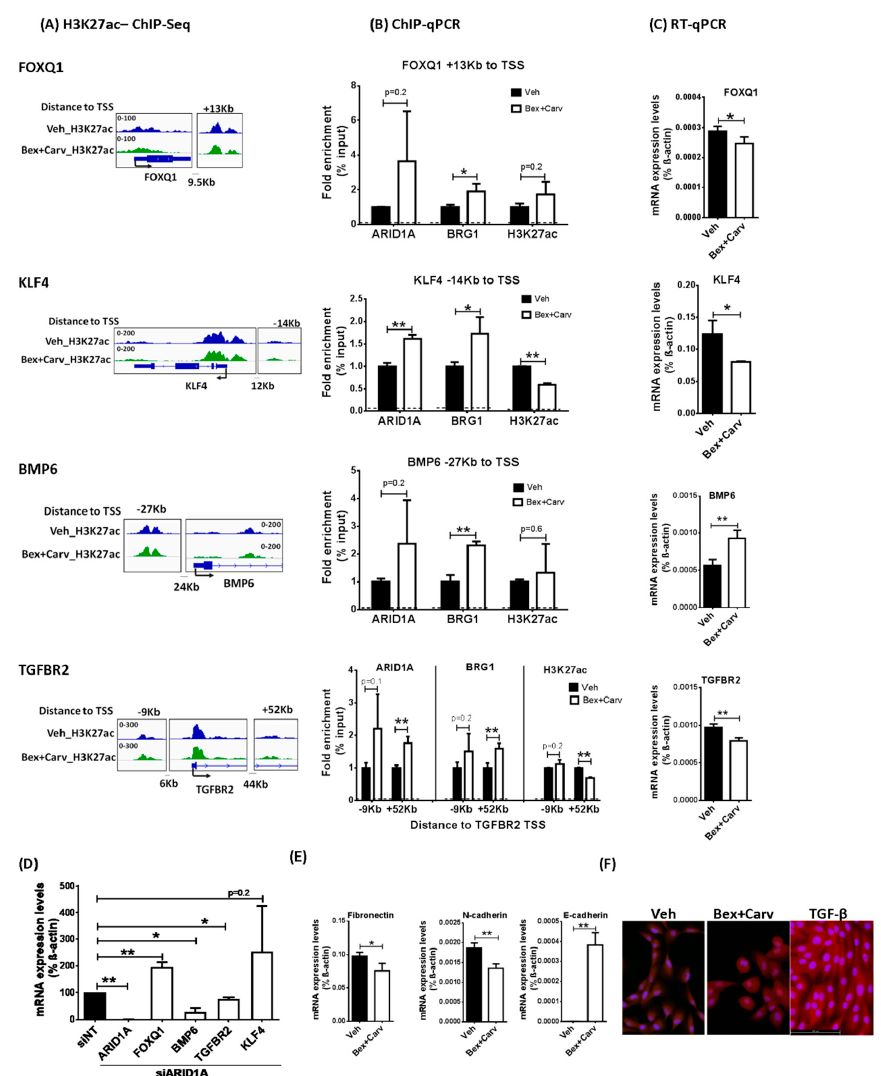
Figure 2. Recruitment of ARID1A to regulatory elements of TGF- β signaling pathway genes upon Bex+Carv treatment and associated change in target gene expression and phenotype in HME-hTert cells. ( A ) ChIP-Seq tracks of H3K27ac in control and Bex+Carv-treated HME-hTert cells across FoxQ1, KLF4, BMP6, and TGFBR2 genes showing the promoter and the studied regulatory regions, exported from the Integrative Genomics Viewer (IGV) application. ( B ) Quantitation of ARID1A and Brg1 enrichment and H3K27ac marks to the putative regulatory elements assigned to FoxQ1, KLF4, BMP6, and TGFBR2 genes after Veh or 100 nmole/L Bex + 1000 nmole/L Carv treatment for 6 h in HME-hTert cells. N = 3 representing 3 biological replicates. The dashed line represents the signal derived from the negative control sample. ( C ) RT-qPCR analysis of target gene transcript levels upon Vehicle or 100 nmole/L Bex + 1000 nmole/L Carv treatment for 6 h in case of KLF4 and BMP6 and 24 h in case of FoxQ1 and TGFBR2. N = 3 representing 3 biological replicates. ( D ) RT-qPCR analysis of ARID1A, FoxQ1, BMP6, and KLF4 gene expression upon 20 nmole/L siRNA transfection for 48 h, and TGFBR2 gene expression upon 72 h of 20 nmole/L siRNA transfection. The gene expression results are presented as a percentage relative to the control sample (siNT). N = 3 representing 3 biological replicates. ( E ) RT-qPCR analysis for the transcript levels of Fibronectin 1 after 24 h, N-cadherin after 6 h, and E-cadherin after 24 h of 100 nmole/L Bex+ 1000 nmole/L Carv combination treatment in HME-hTert cells. The results are expressed as mean ± SD * p < 0.05, ** p < 0.01 by two-tailed Student’s t -test. ( F ) Representative fluorescent images of HME-hTert cell morphology after 72 h of vehicle, Bex+Carv, or TGF- β treatment. Blue: DAPI nuclear stain, Red: CellMask cytoplasmic stain; images taken at 20 ×